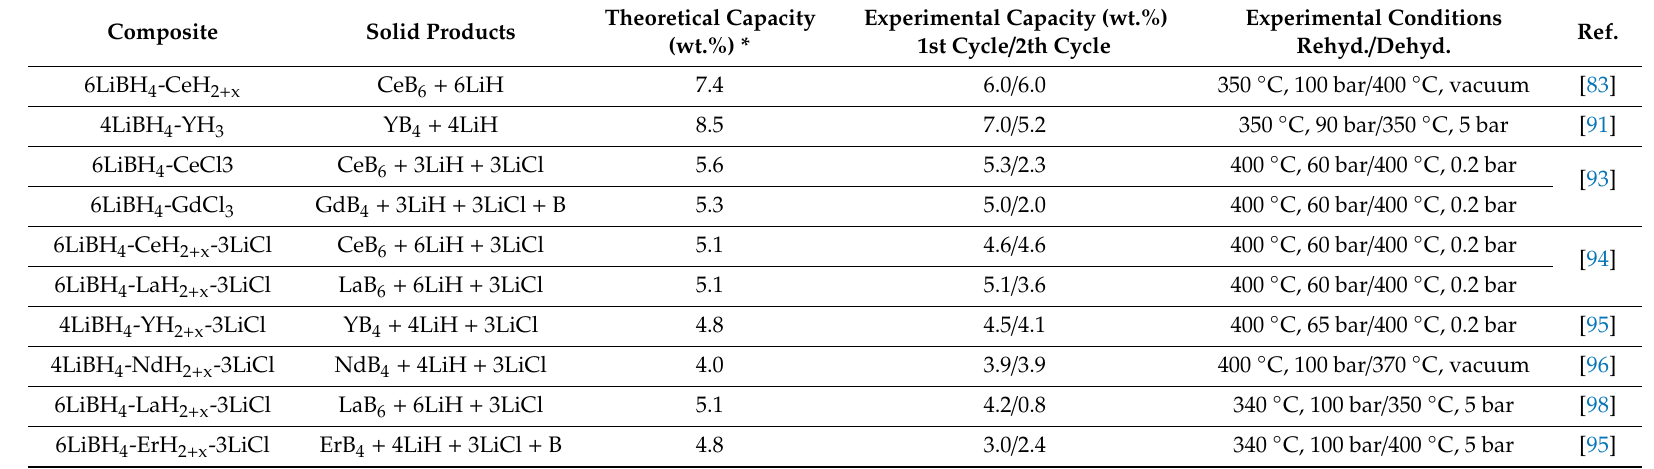
Table 7. Hydrogen storage properties of LiBH 4 -based composites destabilized by interaction with RE hydrides produced using di ff erent